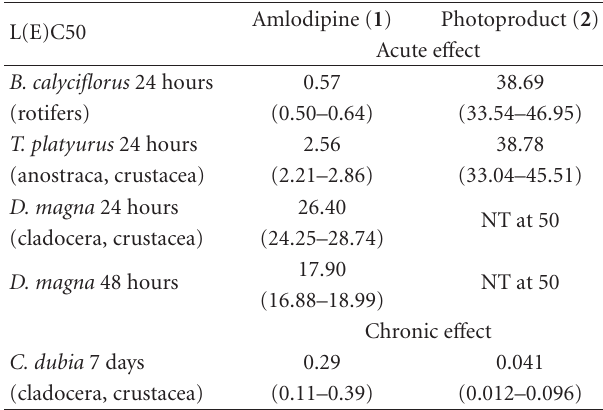
Table 2: Acute and chronic L(E)C50 in mg/L for amlodipine and its photoderivative with the respective confidence limits (95%) for di ff erent organisms of the freshwater chain (NT = not